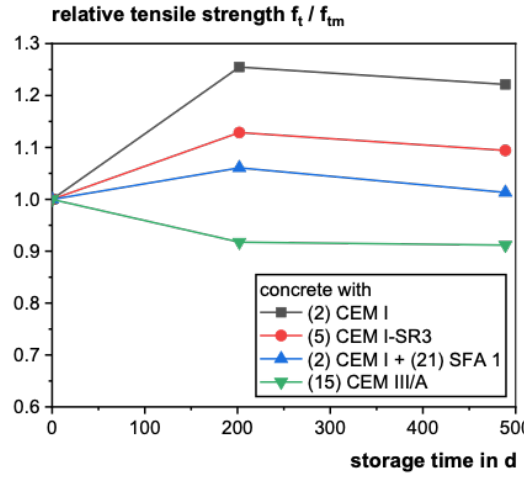
Figure 5. Rel. tensile strength of concretes after more than one year of storage under practical condi-